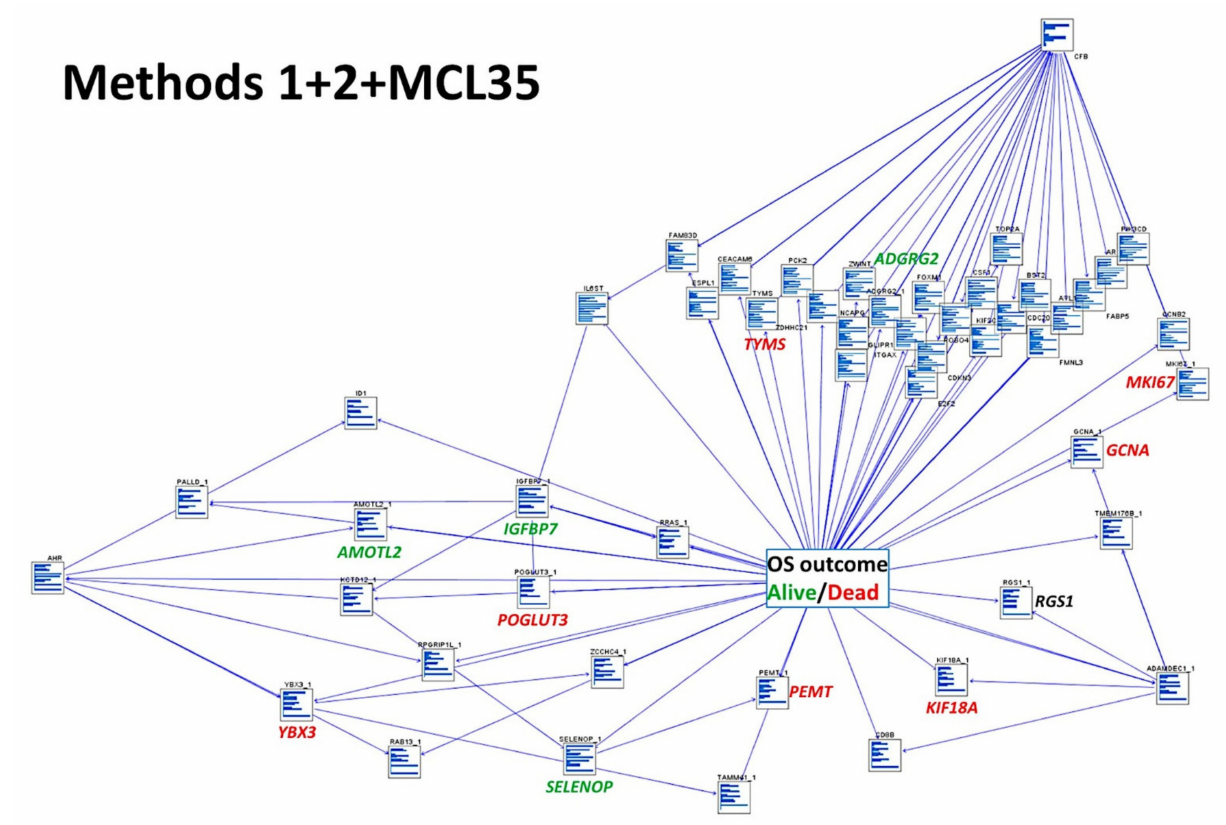
Figure 13. Addition of the MCL35 proliferation signature in a Bayesian network. A Bayesian network modeling was performed using the highlighted genes of both Methods 1 (19 genes) and Methods 2 (15) with the previously identified prognostic genes of MCL of the LLMPP, the MCL35 signature. Some of the most relevant genes are highlighted, in red for the bad, green for the good prognostic genes, and their interrelationships (arrows).